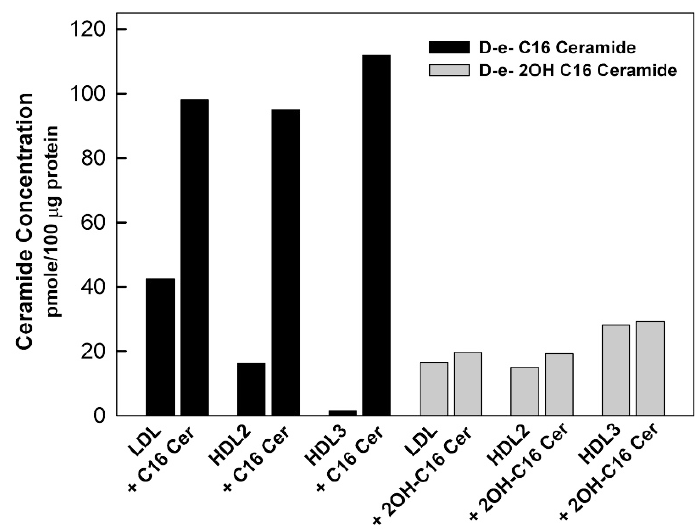
Figure 2. Enrichment of the lipoprotein particles with ceramide. Lipoproteins isolated from healthy volunteers were incubated with 100 µ M of ceramides. After incubation for 24 h at 37 ◦ C, the lipoproteins were dialyzed against PBS and samples of before and after dialysis were analyzed for lipoprotein content. D-e-C16 ceramide had the highest incorporation while D-e-2OH C16 ceramide had low incorporation and D-e-C24 ceramide had no incorporation (Data not shown). Table 1. C16 ceramide-enriched LDL regulate gene expression of metabolic and signaling pathways in human